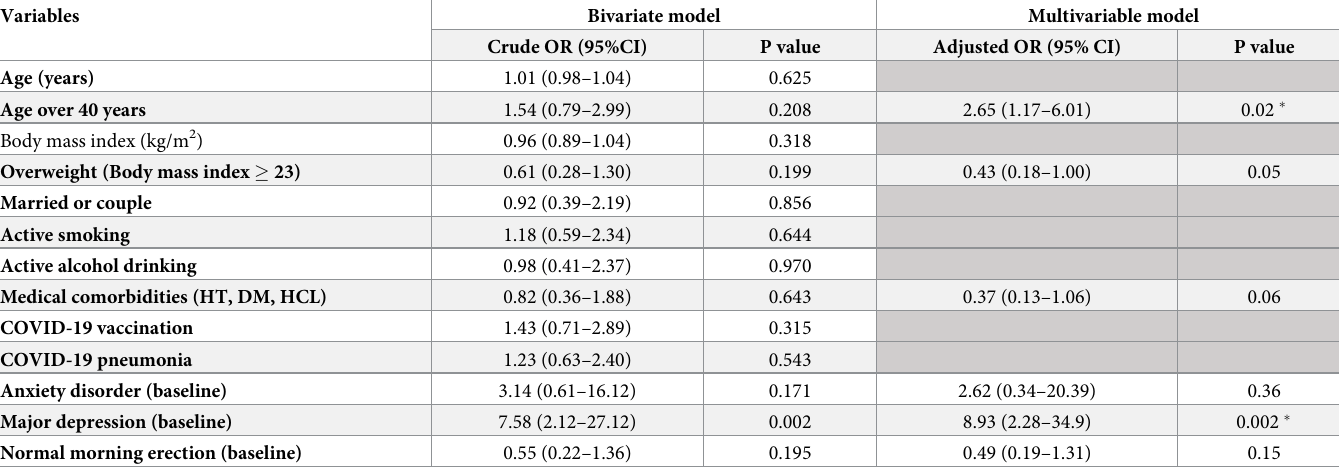
Table 3. Associated factors of erectile dysfunction after three months after recovery from COVID-19 infection using bivariate and multivariable logistic regression